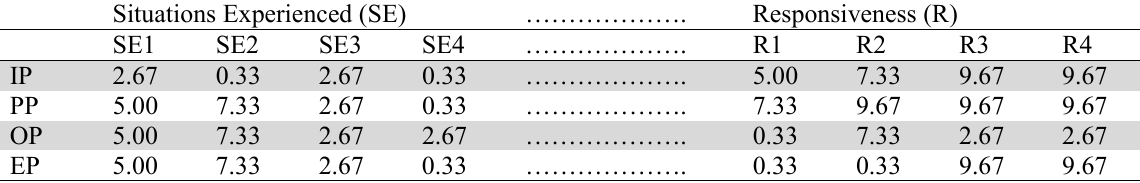
Stage 4: Degrey the decision matrix data and Criteria Importance Weights De-grey the initial grey decision matrix and criteria importance weights to obtain crisp values/data using Eqs. (1– 4) for experts/manager 1. The results are given in Table 6 and Table 7 respectively. Table 6 Showing Crisp decision matrix data for Manager 1 Situations Experienced (SE)